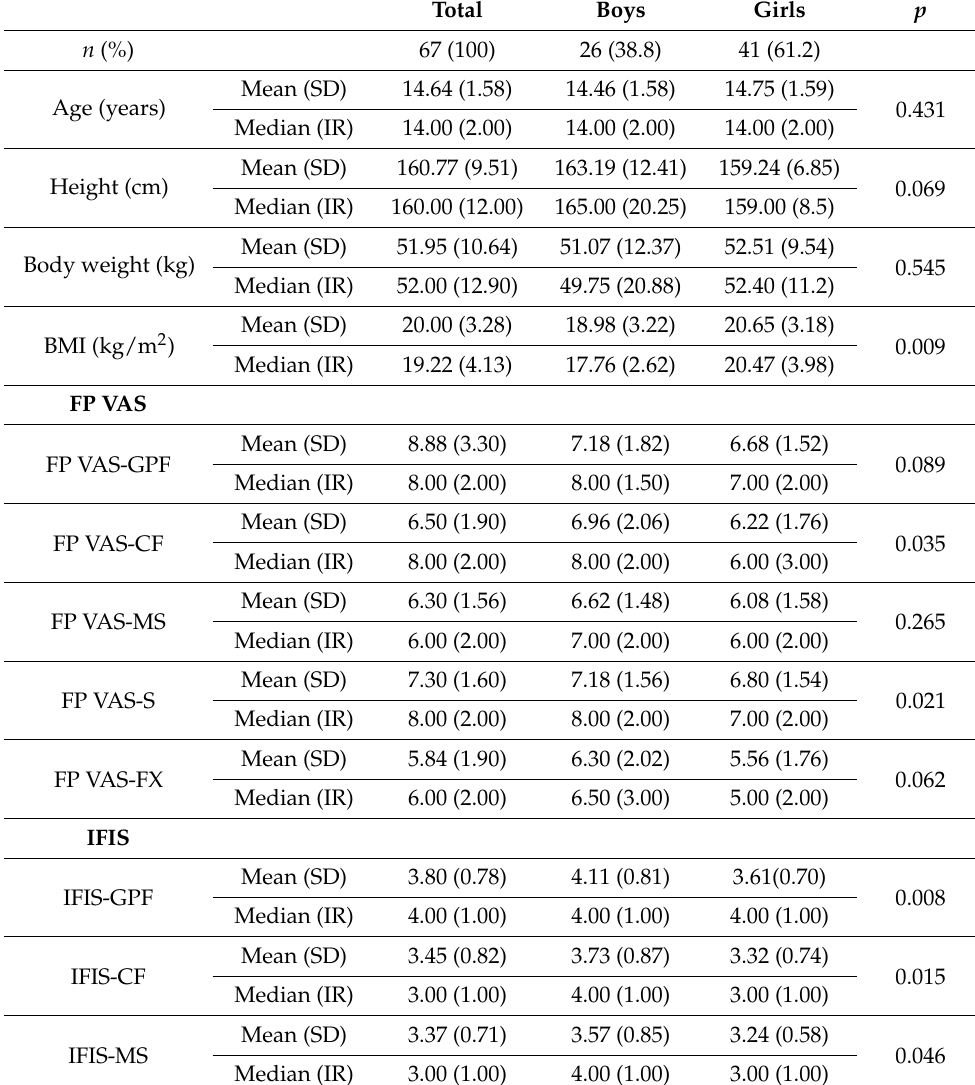
Table 1. Participants’ anthropometry, FP VAS A and IFIS values and level of